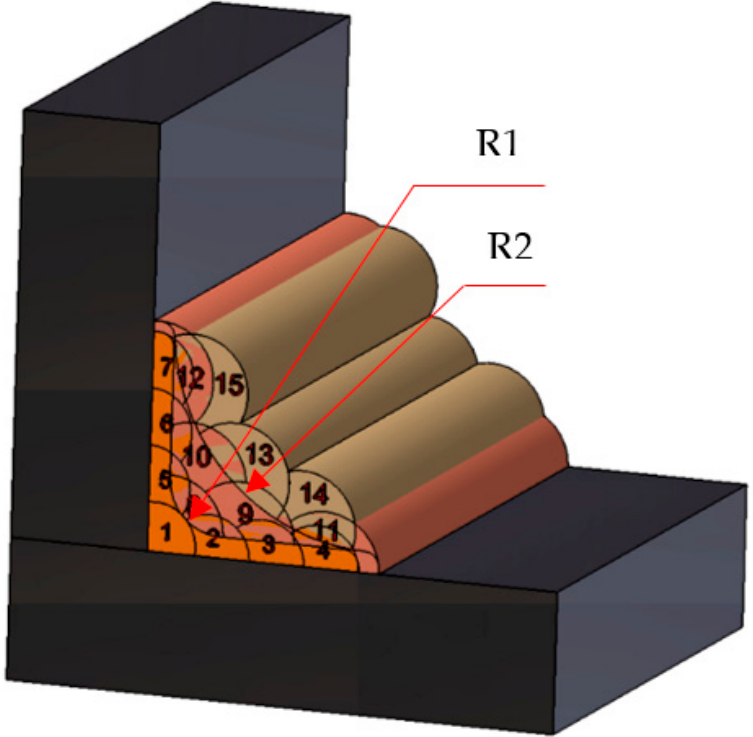
Figure 2. The order of deposition of the welding beads.